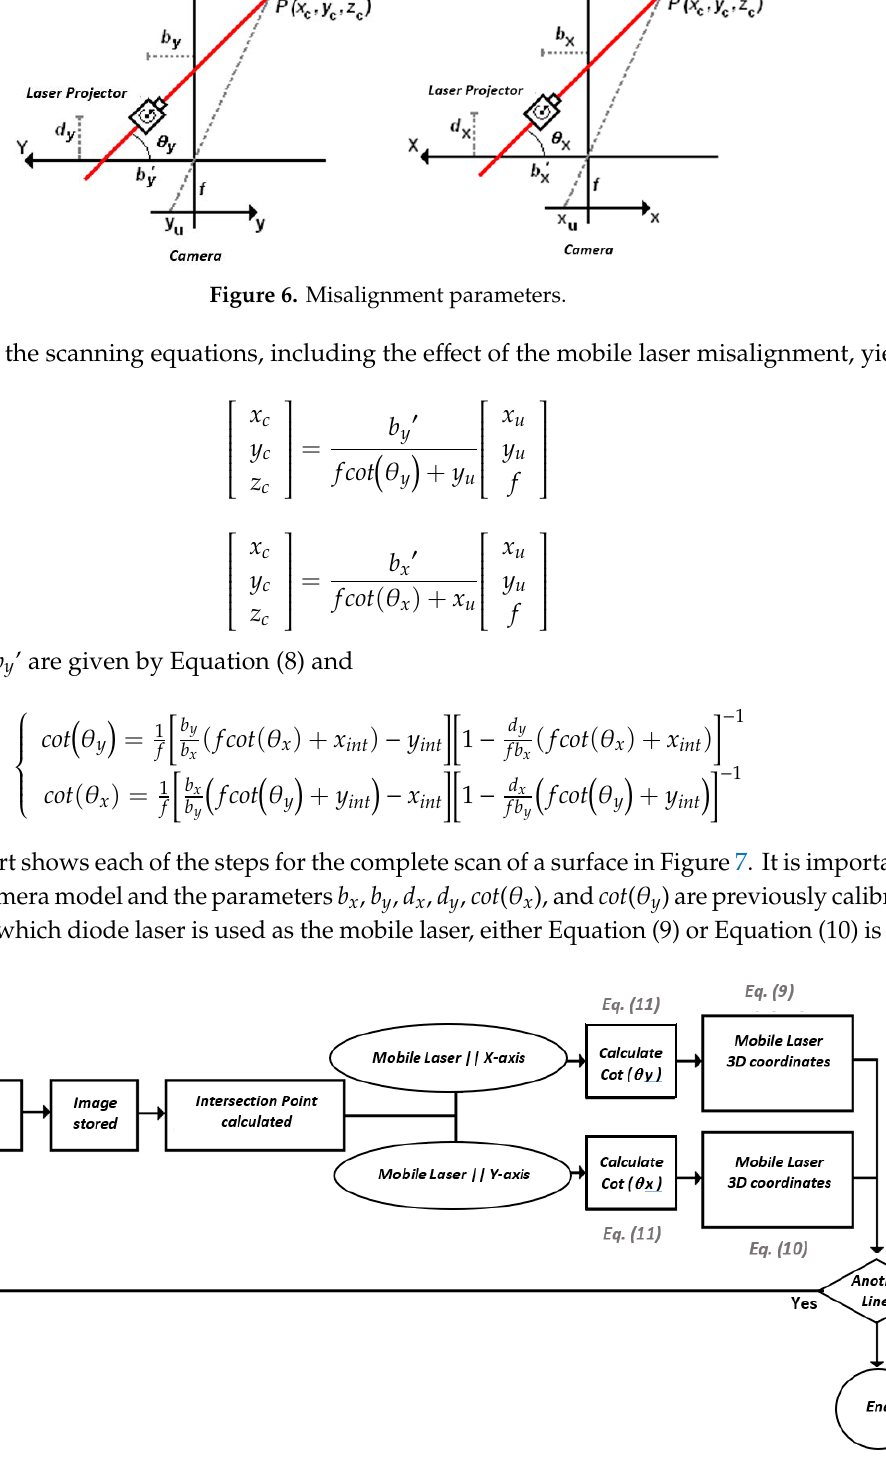
Figure 7. Surface scanning algorithm.